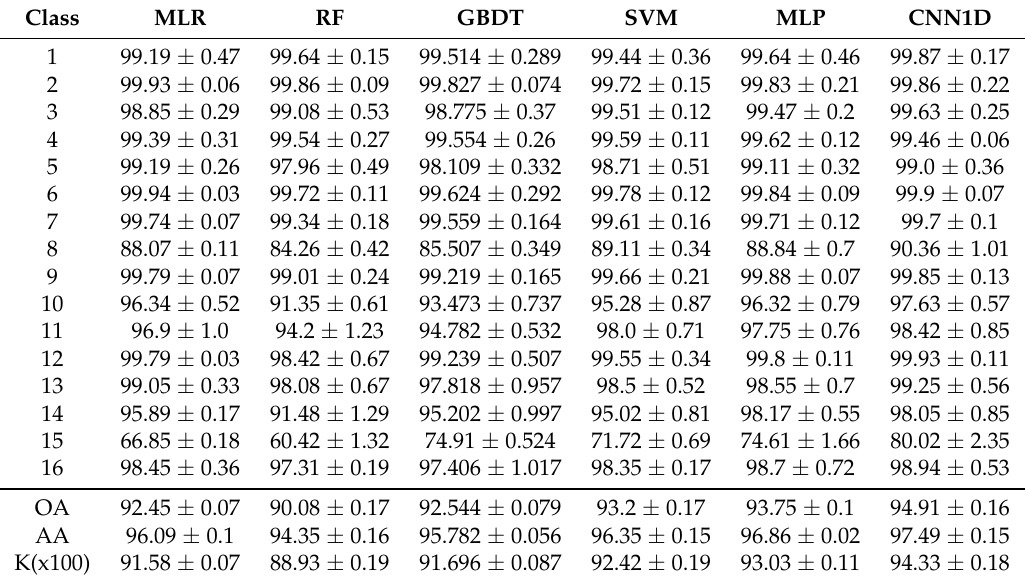
Table 8. SV data set